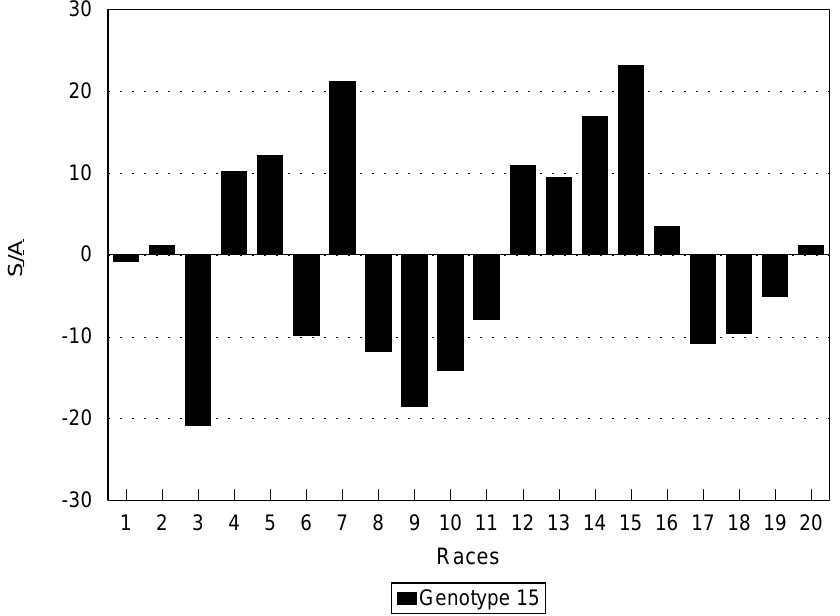
Figure 3 - Specific interaction ability (SIA) of host 15 inoculated with different pathogen races according to interactive model.